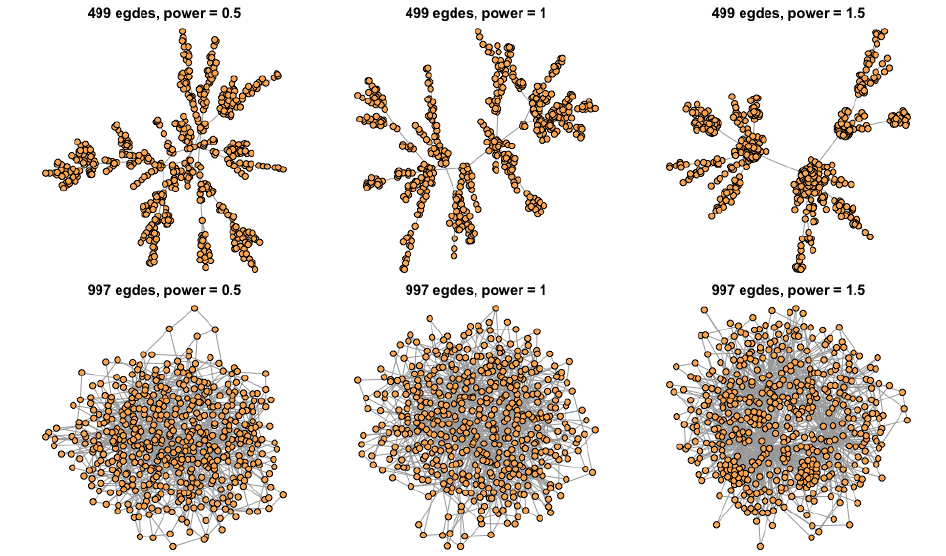
Figure 4. Scale-free graphs with p = 500 nodes generated with different values of parameters m (in rows) and power (in columns). The graphs correspond to one of the 20 random realizations generated in this simulation setup.